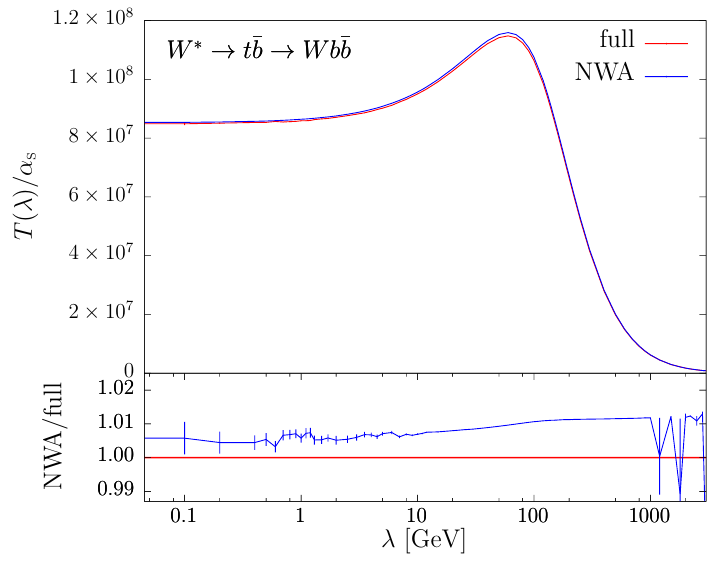
Figure 3 . T ( (cid:21) ) for the NLO total cross section, as function of the gluon mass (cid:21) , computed in the pole-mass scheme using the exact full matrix elements, in red, and the narrow-width approximation, NWA, in